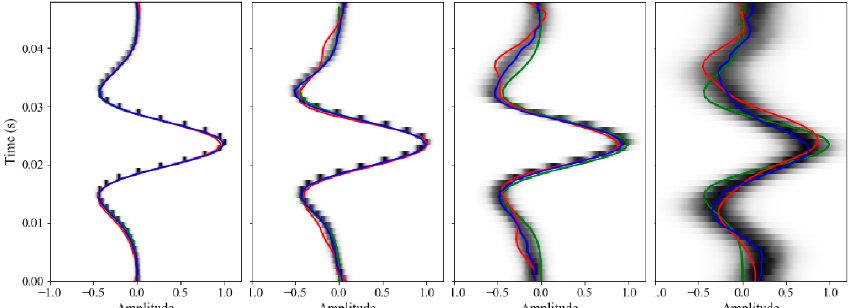
Figure 4. The results of wavelet extraction and their probability density obtained from seismic data with different noises level (the variances are 10 − 5 , 10 − 4 , 10 − 3 , and 10 − 2, respectively, from left to right). Blue lines are the wavelet mean model and red lines are one sample of 5000 wavelet simulations. The gray–black color represents the probability density. The green lines are the true Ricker wavelet used in synthetic seismic data.